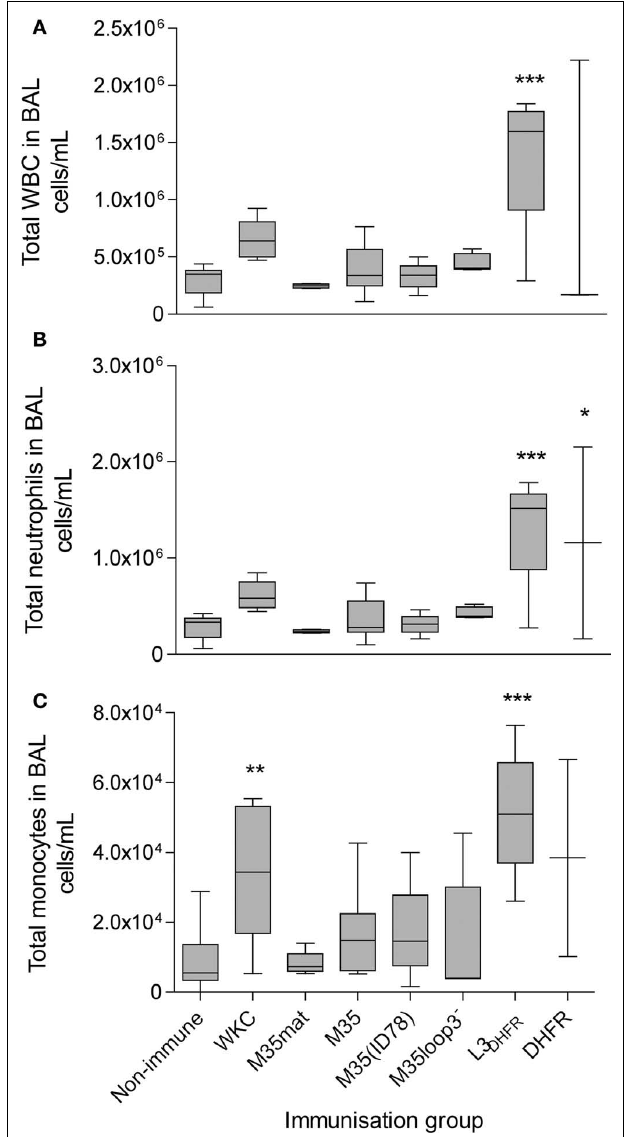
FIGURE 6 |The counts of white blood cells in the BAL fluid. (A) Total WBC, (B) total neutrophils and (C) total monocytes.Values shown are log 10 cell/mL. Boxes represent the 25th–75th percentile, the line through the box indicates the median and the whiskers extend between the highest and lowest values. Asterisks indicate statistical significance compared to the non-immunized control group: * p < 0.05, ** p < 0.01, *** p <